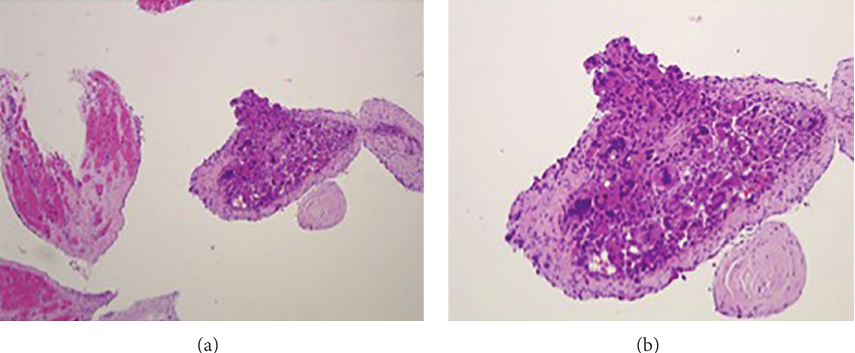
Figure 7: Trichrome stain showing moderately differentiated hepatocellular carcinoma with fragments of myocardium and mild subendocardial